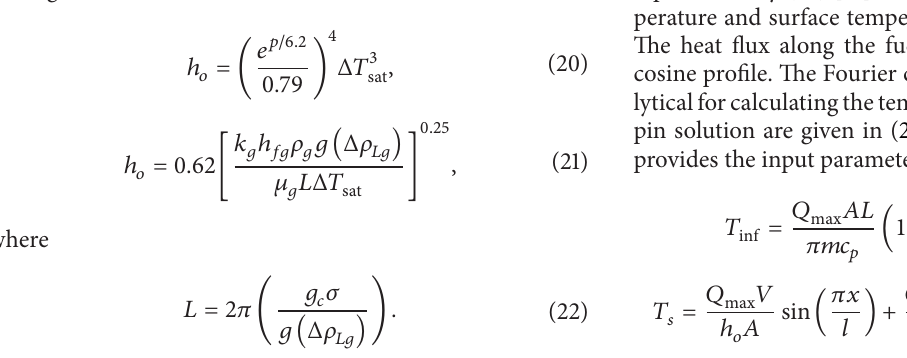
and modified Bromley correlation (see (21)) is used for film